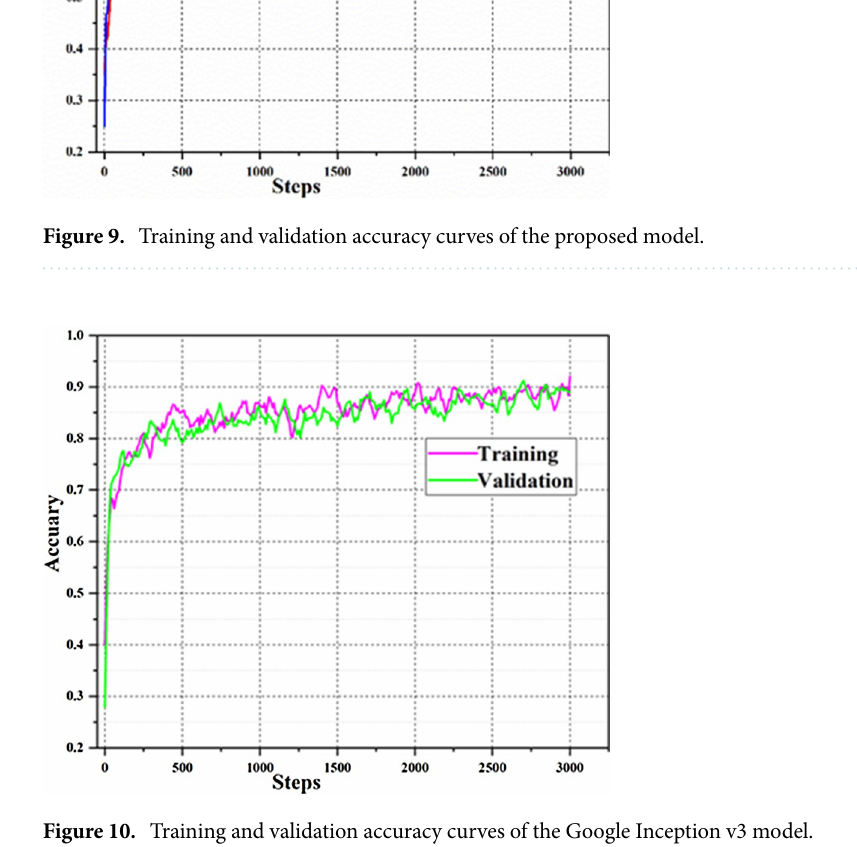
Figure 10. Training and validation accuracy curves of the Google Inception v3 model.